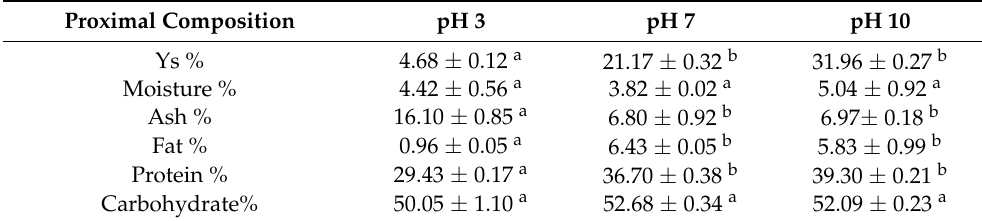
Table 1. Extraction yields (Ys %) and the proximal composition of hydrocolloids from butternut squash seeds at pH 3, 7, and